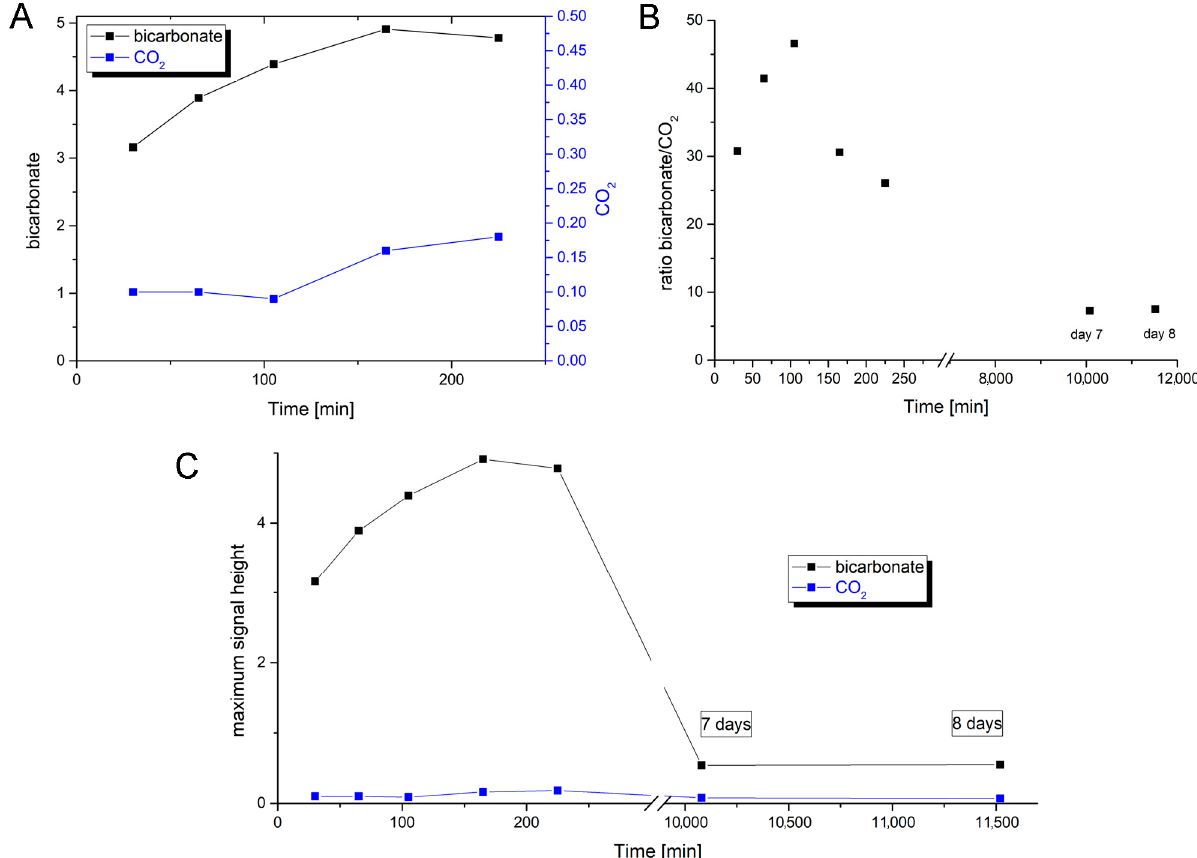
Figure 5. Time-dependent abundance of intermediate and final products of enzymatic formate oxidation. ( A ) The development of the maxima (signal height) of the resonance signals for bicarbonate (black, left y-axis) and CO 2 (blue, right y-axis) up to 225 min. ( B ) Time-dependent development of the ratio of bicarbonate content versus CO 2 content derived from the maxima of the resonance signals in the NMR spectra. This includes measurements after 7 and after 8 days to confirm that the bicarbonate/CO 2 equilibrium has settled. ( C ) The development of maxima (signal height) of the resonance signals for bicarbonate (black) and CO 2 (blue) with a joint y-axis reflecting their relative abundance in the NMR sample tube over time. This includes measurements after 7 and after 8 days to confirm that the bicarbonate/CO 2 equilibrium has settled. The experiment was carried out at 5 °C and pH 9 with an azide-inhibited enzyme and a 13 C-labeled formate substrate.